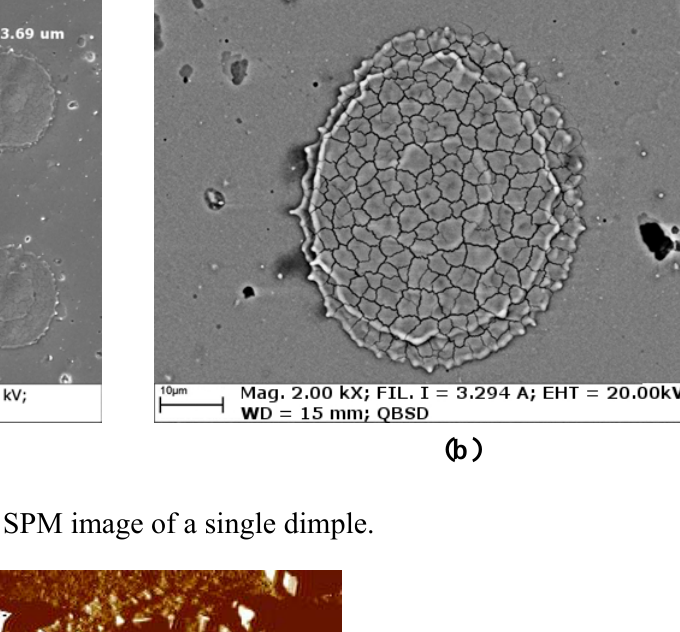
Figure 5. Morphology of laser treated TiN surface: ( a ) dimples array; ( b ) single dimple .